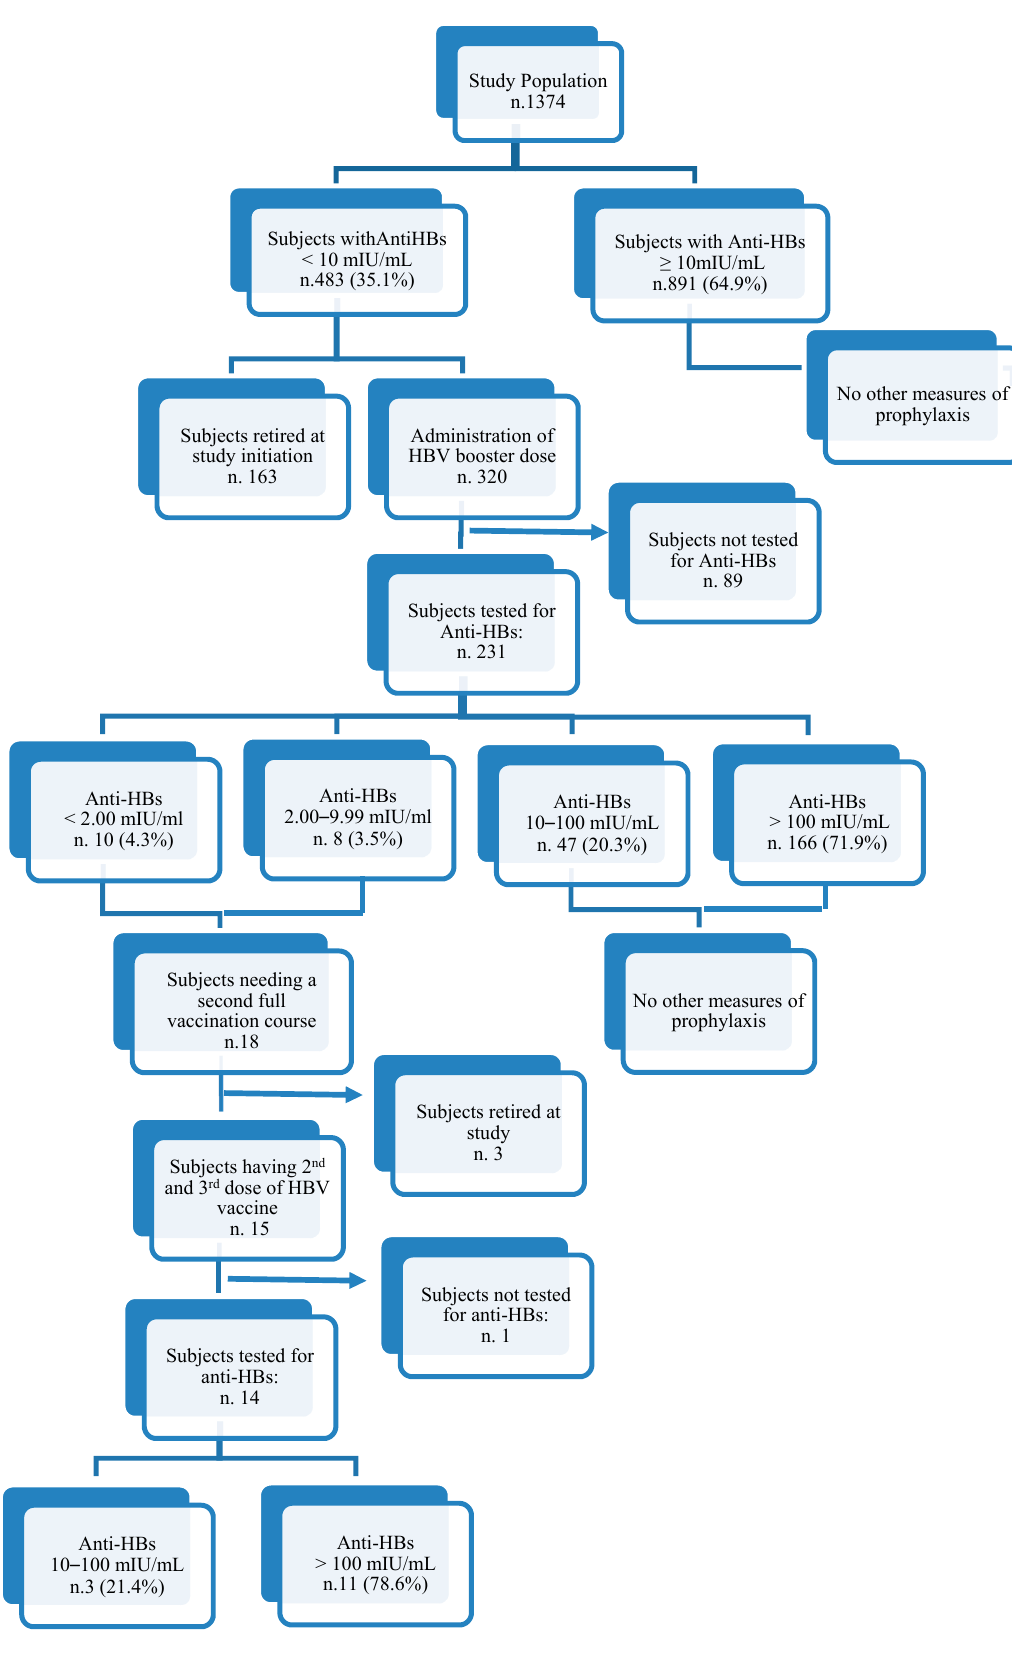
Figure 2. Study results flow